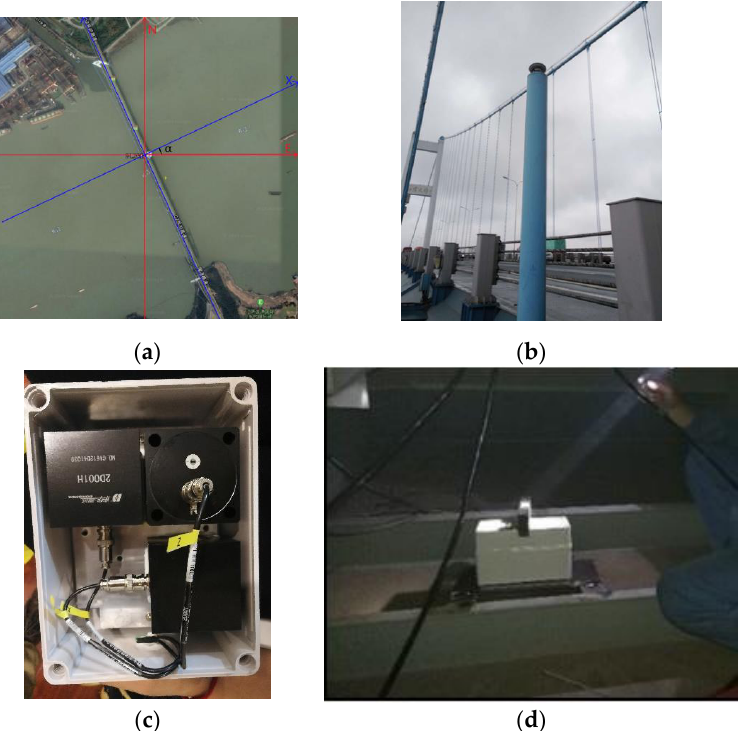
Figure 17. Orientation of Jiangyin Bridge and equipment installation. (a) Satellite image of Jiangyin Bridge and coordinate system relationship; (b) GNSS antenna position and observation pier; (c) the internal of Speedometer; (d) speedometer installation.